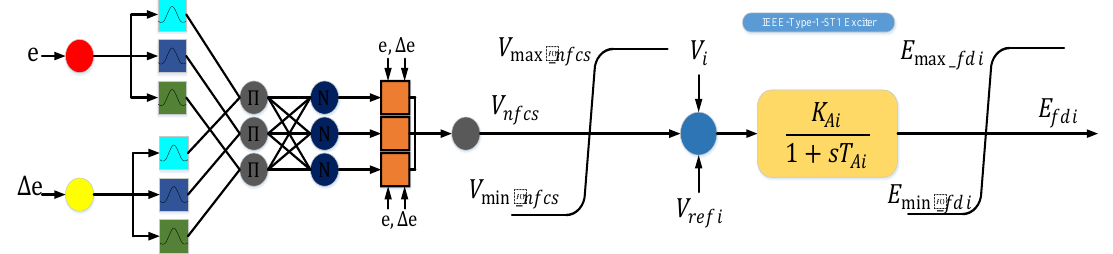
Figure 20. Two-input Sugeno-type NFC structure connected to STIA IEEE excitation system [44].